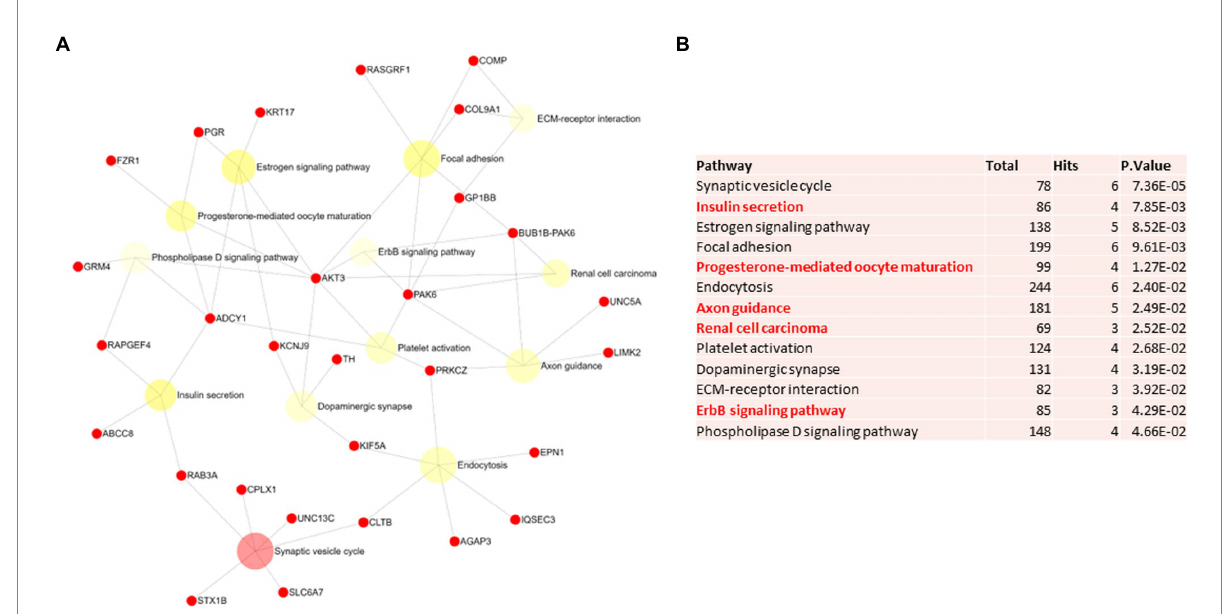
FIGURE 4 Pathway analysis of switch genes from asymptomatic females with Alzheimer’s disease (F-asymAD). (A) Biological and functional analysis of switch genes from F-asymAD compared to controls was performed in NetworkAnalyst. Switch genes are depicted in red. (B) The pathways are ranked according to the number of hits and lowest value of p. Pathways are derived from the KEGG database. The unique pathways are shown in red.